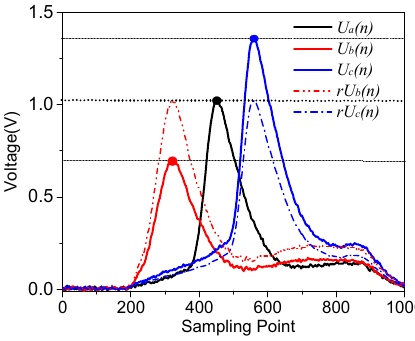
Figure 5. Normalization process of one FBG at different wavelengths.